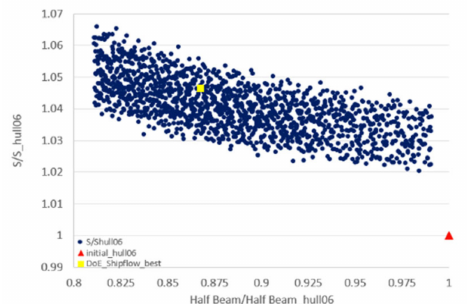
Figure 9. Wetted surface of parametrically generated 850 designs for a 30 m catamaran with fixed displacement and demihull length WL as ratio to demihull’s beam constraint; square symbol: best for beam constraint at 0.8, triangle symbol: best with beam constraint at